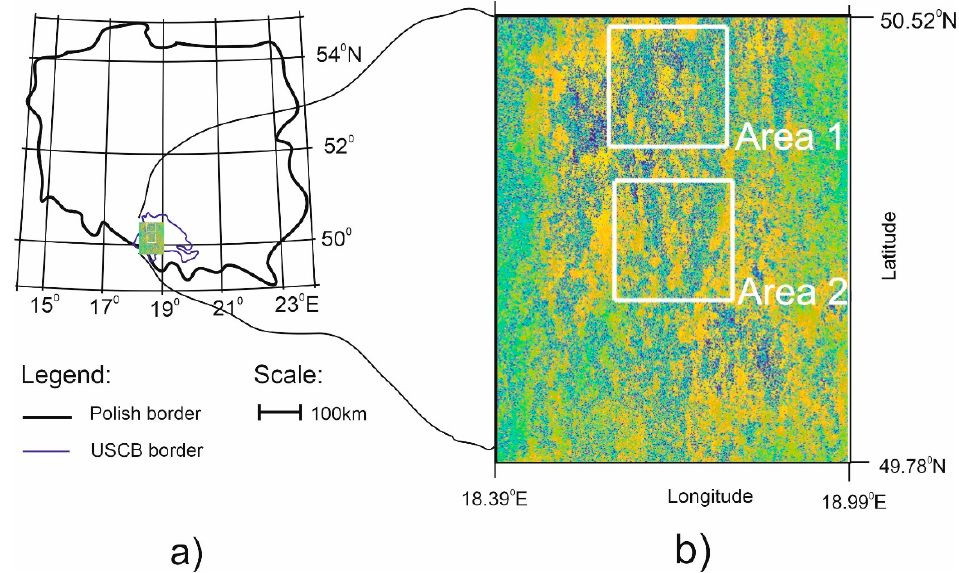
Figure 8. Differential, unwrapped interferogram generated for recordings performed on 10 and 22 October 2016. It was computed from radar images of the Upper Silesian Coal Basin area, Poland ( a ). White squares in the interferogram ( b ) indicate areas with a high concentration of interferometric fringes. These two areas (Area 1 and Area 2) were selected for testing the proposed detection method.